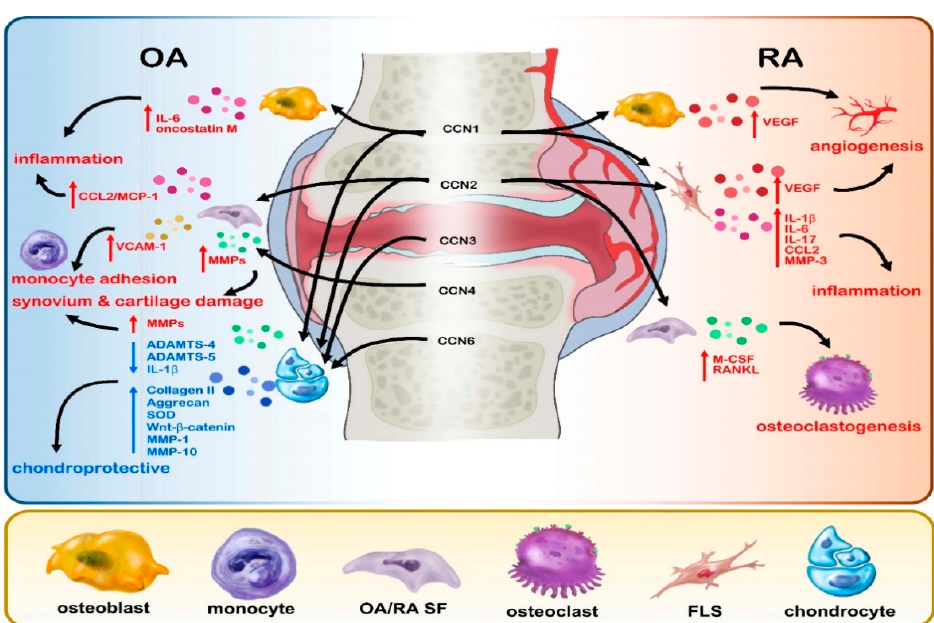
Figure 1. Graphical representation of the effects of CCN proteins 1–6 in RA and OA disease.